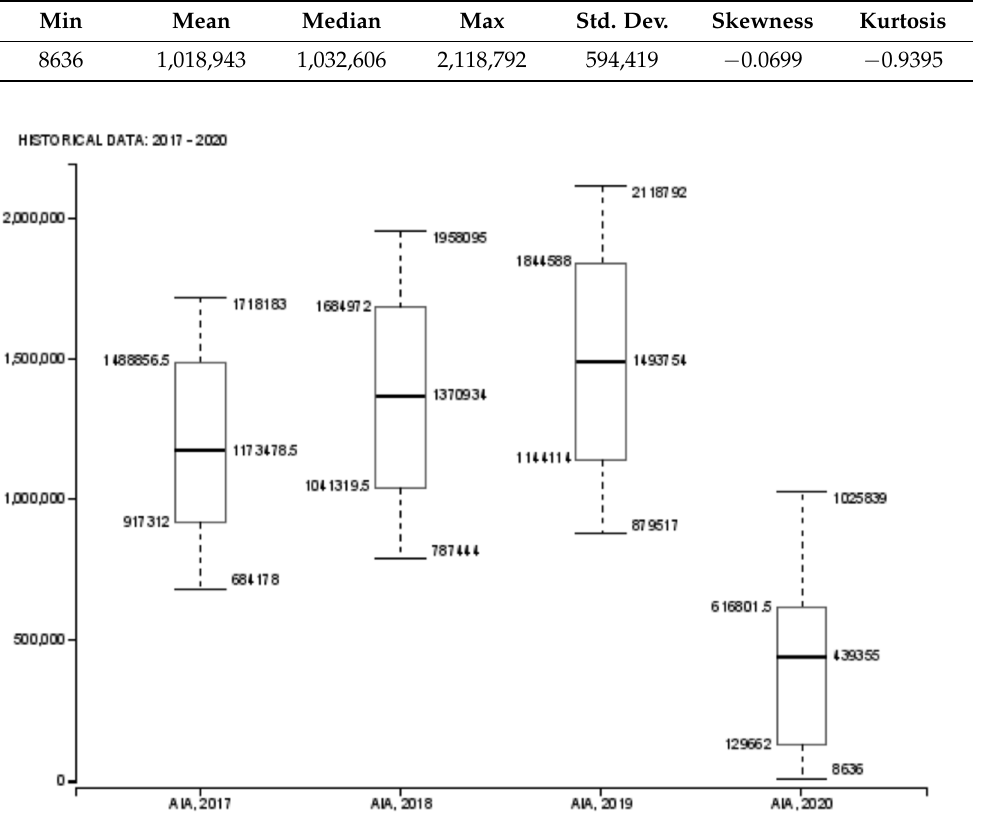
Figure 6. Box plots for annual international pax traffic in AIA from 2017 to 2020. (The box plots for AIA were drawn with the KNIME Analytics Platform. All measures (median, quartiles) were calculated directly from the data sets.)